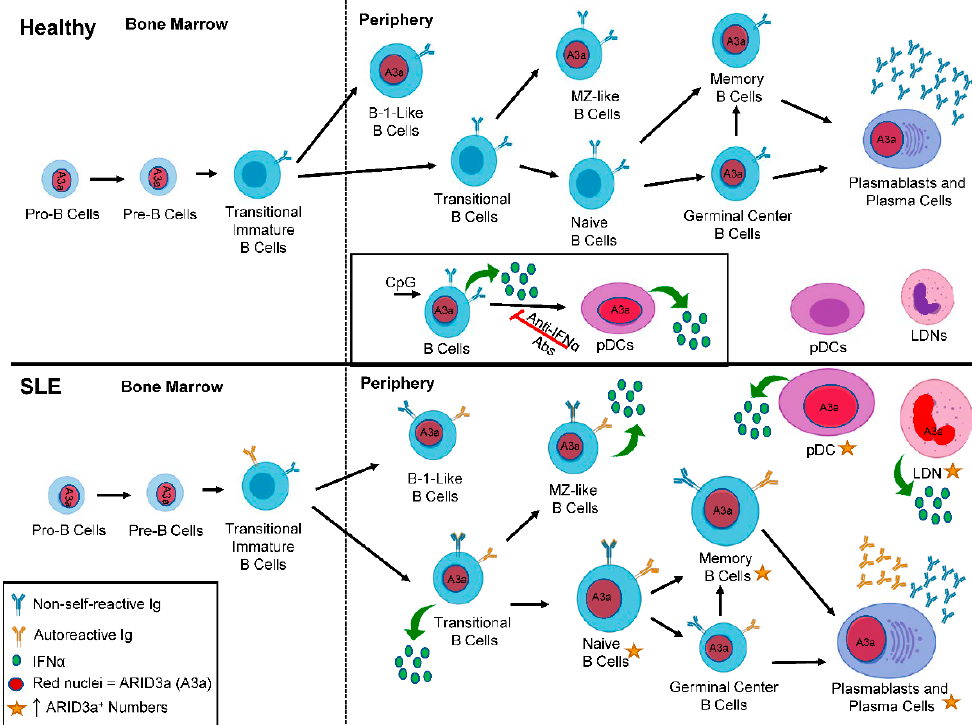
Figure 2. ARID3a expression is enhanced in systemic lupus erythematosus (SLE) B cell subsets compared to healthy controls. A diagram depicts B lineage development in healthy (top panel) and SLE patients (bottom panel) from the bone marrow to the periphery. Red nuclei denote cell subsets that express ARID3a. The inset shows the induction of ARID3a and interferon alpha (IFN α ; green circles), and the effect of those ARID3a-expressing B cells on healthy pDCs. In SLE patients, larger cells and gold stars indicate those cell subsets with increased numbers of ARID3a + cells and associated IFN α production. Blue immunoglobulin (Ig) indicates non-self-reactive Ig, while gold Ig indicates the subsets of cells that can also produce autoreactive Ig. pDCs—plasmacytoid dendritic cells; LDN—low density neutrophils; A3a—ARID3a.